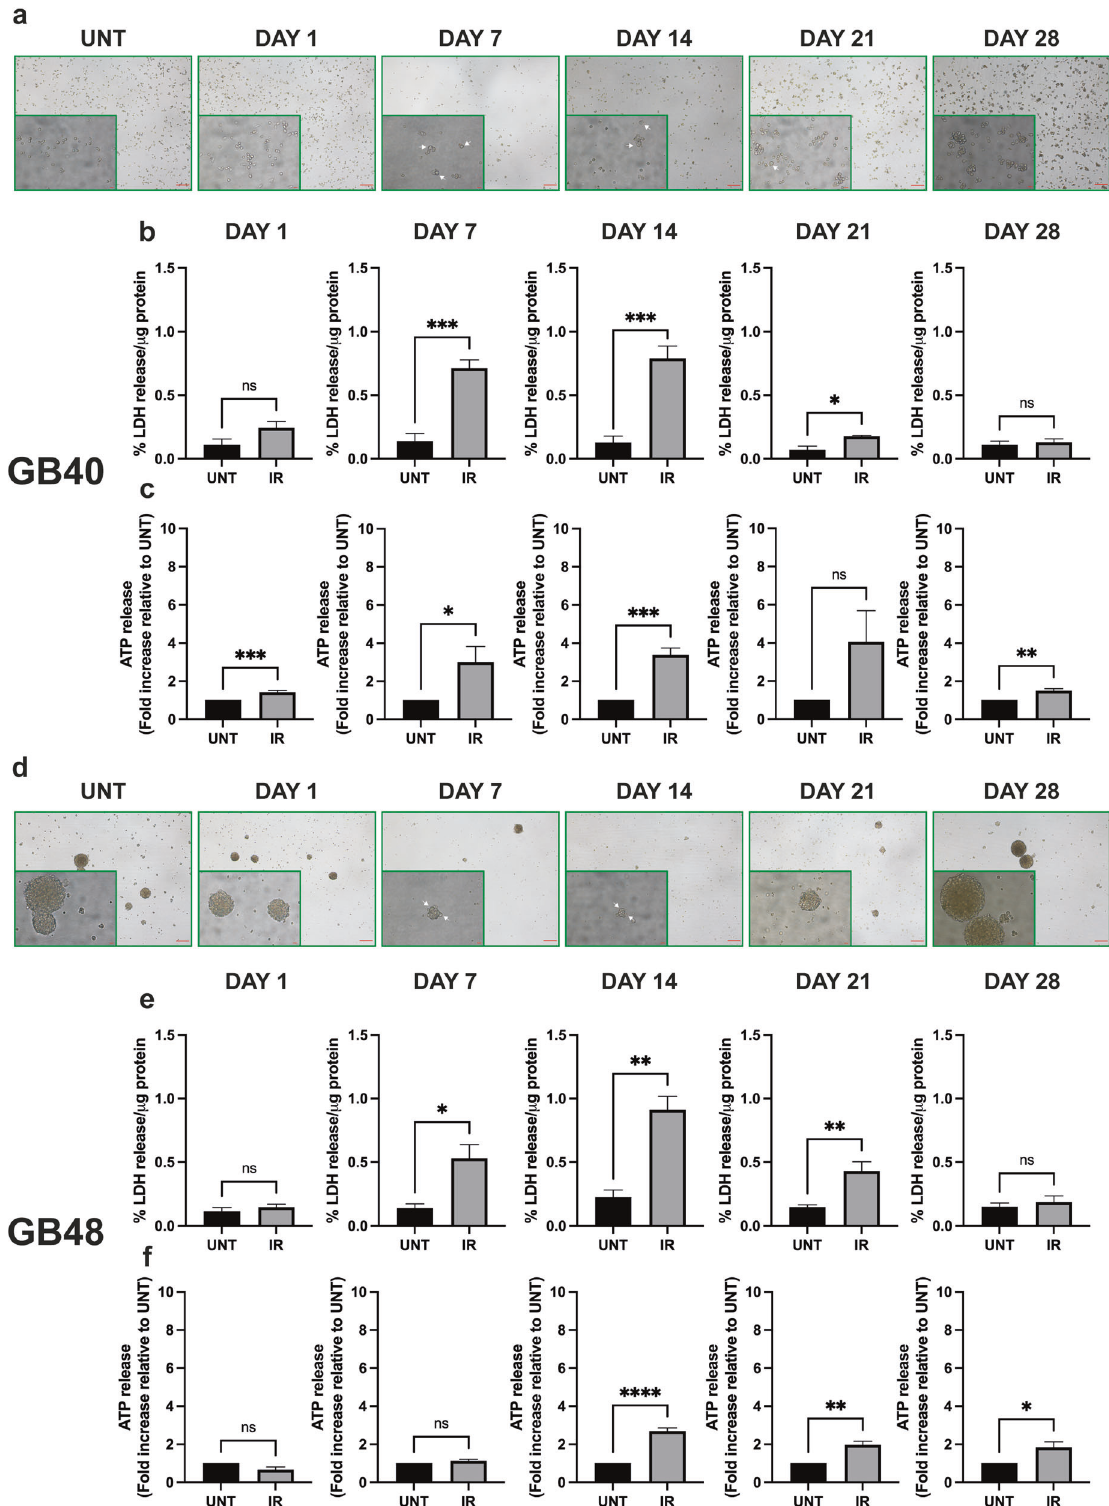
Fig. 4 Radiation triggers cell death and ATP release in GBM cells. a , d Bright fi eld images of GB40 and GB48 cells at increasing intervals after radiation treatment with 7.5 Gy dose. Scale bars = 200 μ m for largest images and 20 μ m for insets. The white arrow indicates swollen GBM cells. b , e Radiation-induced percent LDH release normalized to the total amount of protein (µg). Data are shown as mean ± SEM; n = 4. Statistical analyses were conducted with unpaired two-tailed Student ’ s t -test. c , f Radiation-induced ATP release measured in the culture supernatants. Data were normalized on the total amount of protein (µg) and reported as a relative increase in eATP released by irradiated cells compared to untreated cells at each time point. Data are shown as mean ± SEM, n = 5. Statistical analyses were conducted with unpaired two- tailed Student ’ s t -test. P values: n.s not signi fi cant; * P ≤ 0.05; ** P ≤ 0.01; *** P ≤ 0.001; **** P ≤ 0.0001.